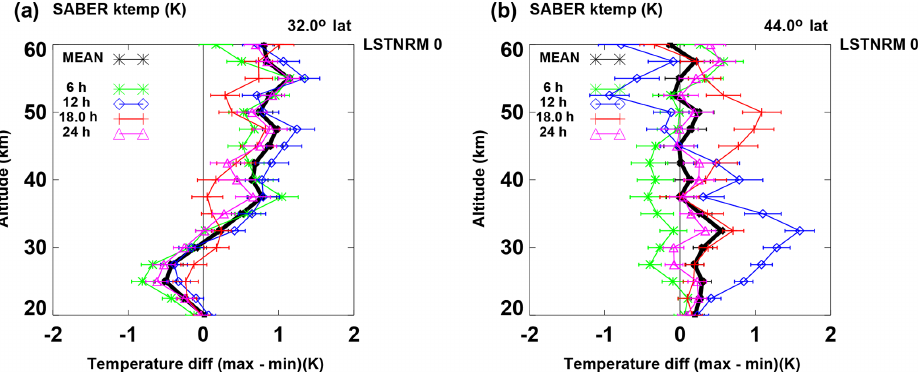
Figure A2. As in Fig. A1, but for temperature responses at 32 ◦ (a) and 44 ◦ from 20 to 60km. Values are responses at solar max minus responses at solar min (K/100sfu). Black asterisks denote our responses based on zonal means that are averages over both longitude and local time. Green asterisks denote our responses of zonal means at 6LST, blue diamonds denote our responses of zonal means at 12LST, red plusses denote our responses of zonal means at 18LST, and magenta triangles denote our responses of zonal means at 24LST, based on SABER